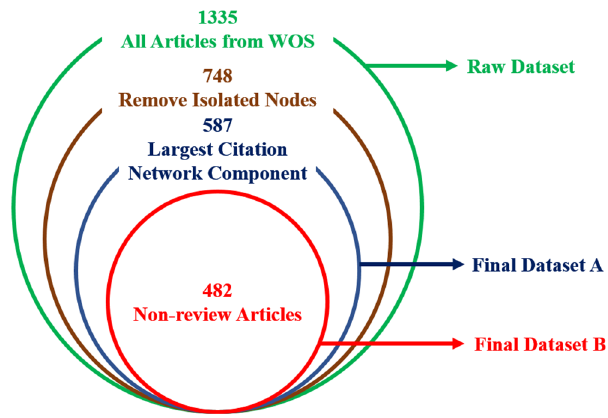
Figure 2. Collected datasets for MPA.